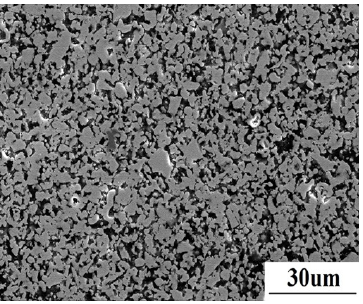
Figure 1. The microstructure of as ‐ sintered ZrB 2 /SiC composite.